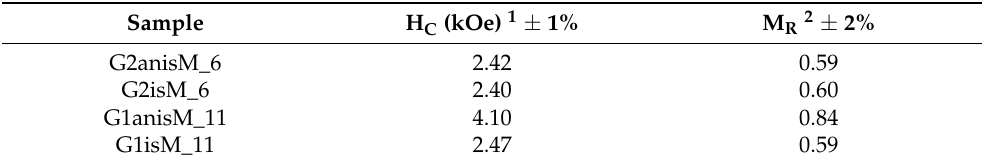
Table 8. Magnetic data relative to the composite geopolymer samples, labeled as in column